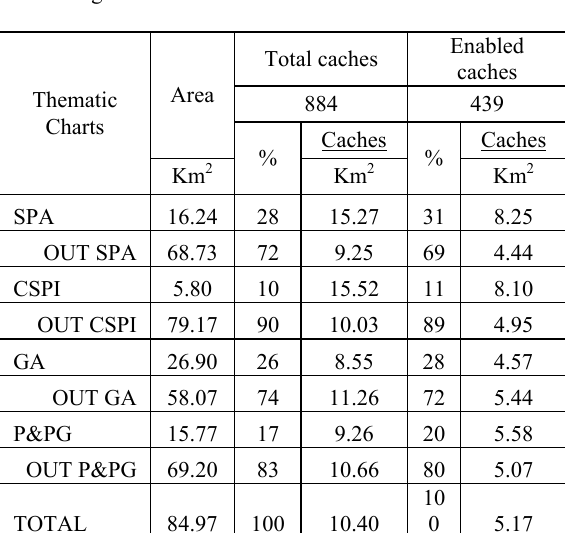
Table 4. TOP15 Lisbon Caches Questionnaires